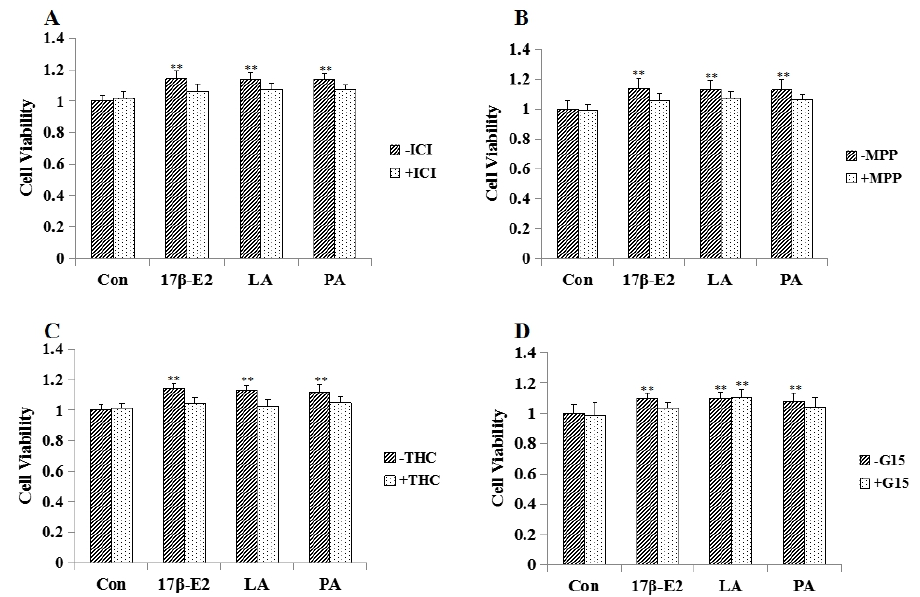
Figure 6. Effect of estrogen receptor antagonists on PA aroused MCF-7 cell proliferation ( n = 3). ( A ) Effects of unspecific ER antagonist (ICI182780) on PA stimulated MCF-7 cell proliferation. ( B ) Effects of methylpiperidino-pyrazole (MPP) on PA stimulated MCF-7 cell proliferation. ( C ) Effects of Delta (9)-tetrahydrocannabinol (THC) on PA stimulated MCF-7 cell proliferation. ( D ) Effects of specific GPR30 antagonist G-15 (G-15) on PA stimulated MCF-7 cell proliferation. * p < 0.05; ** p < 0.01 compared to controls.